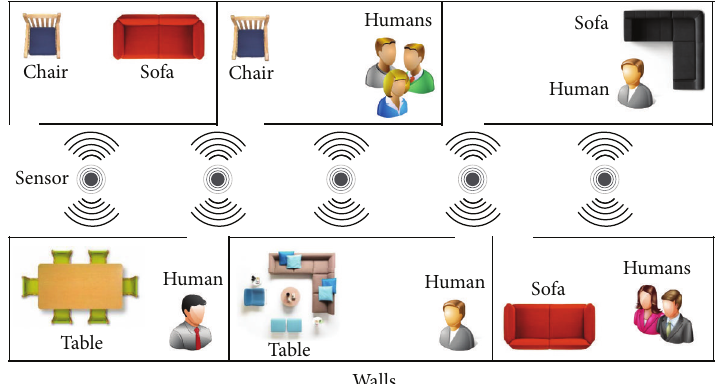
Figure 1: System model to represent indoor location and devices placement.